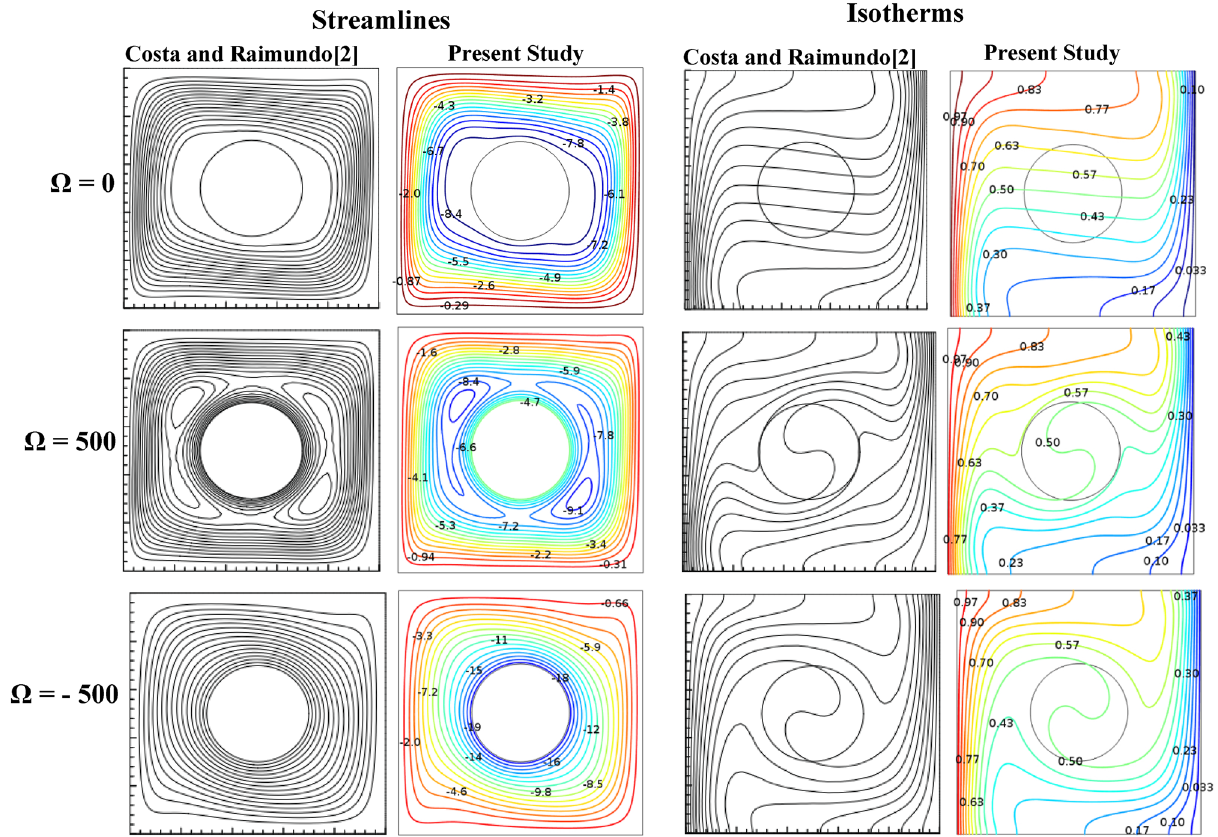
Figure 3. Comparison of streamlines and isotherms between Costa and Raimundo 2 and present study at different angular rotational velocities Ω (R = 0.4 H, Rc = 1, and R k =